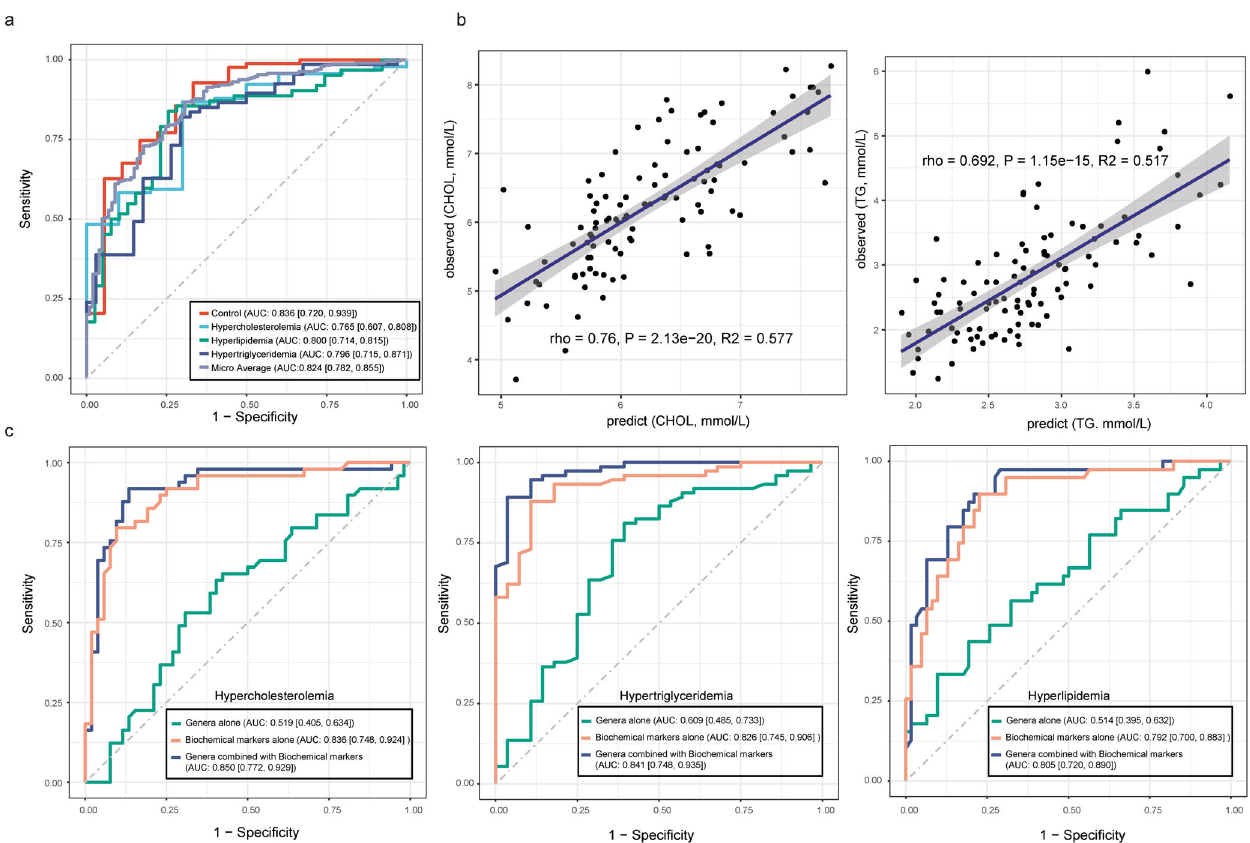
Fig. 6 Prediction of dyslipidemia using gut microbiome and biochemical tests and cross-validation. a Prediction performance of dyslipidemia using random forest classi fi ers trained on the genus-level taxonomic pro fi les and biochemical test levels of the gut microbiome. Numbers in parentheses represented the 95% con fi dence interval of the AUC. b Prediction performances of TG levels and CHOL levels using random forest regression models trained on the genus-level taxonomic pro fi les of the gut microbiome and biochemical test levels. P values in the plots showed P obtained from the linear regression. c Prediction performances of dyslipidemia groups using random forest classi fi ers trained on various pro fi les of the gut microbiome and biochemical test levels. Numbers in parentheses represented the 95% con fi dence interval of the